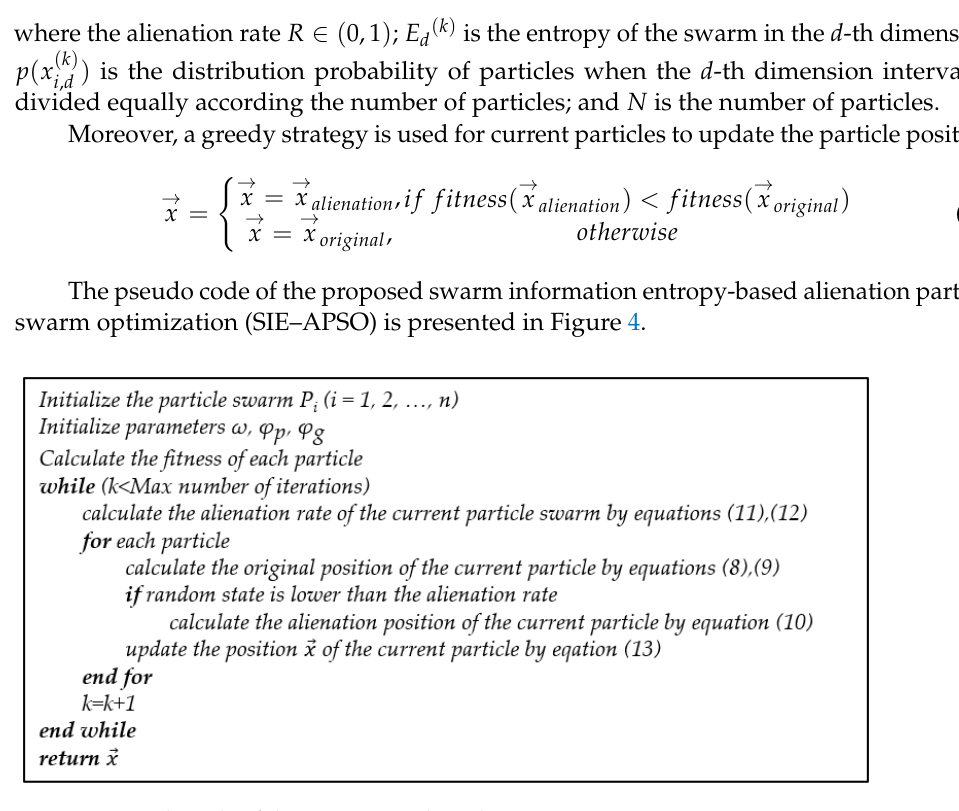
Figure 4. Pseudo code of the SIE – APSO algorithm.